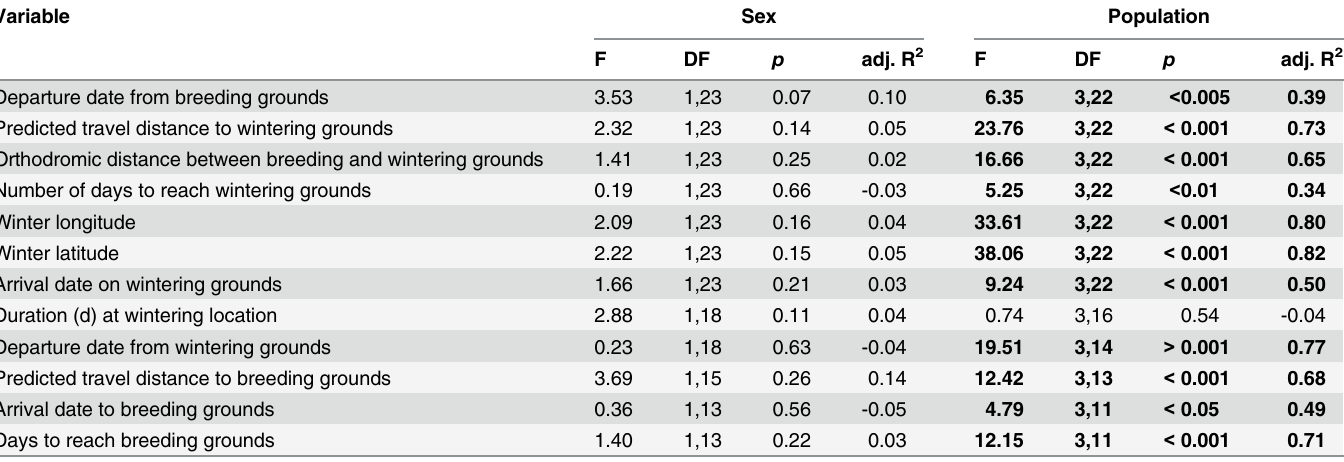
Table 2. Results from linear models used to describe differences in breeding and wintering ground phenology, wintering locations and migration routes for male and female barn swallows fit with archival light-level geolocators (n = 27) from four populations in North America, 2011 –